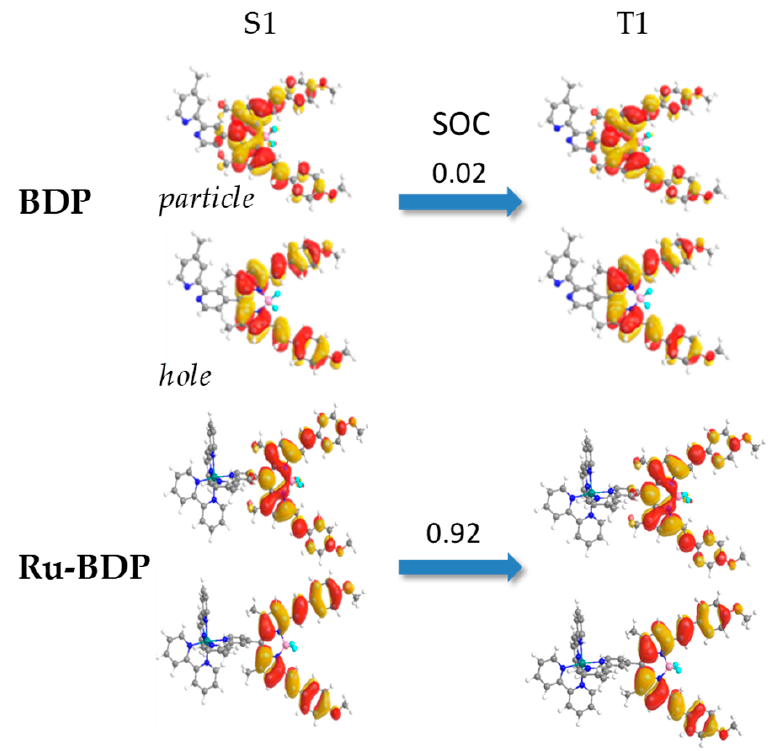
Figure 2. Natural transition orbitals (hole and particle) computed for S1 and T1 of BDP and Ru- − 1 are also BDP. SOC values in cm − 1 are also provided. SOC values in cm